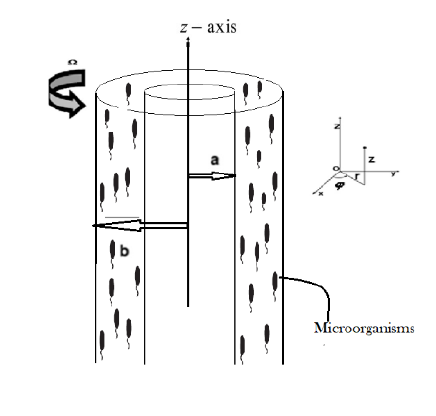
Figure 1. Geometry of the